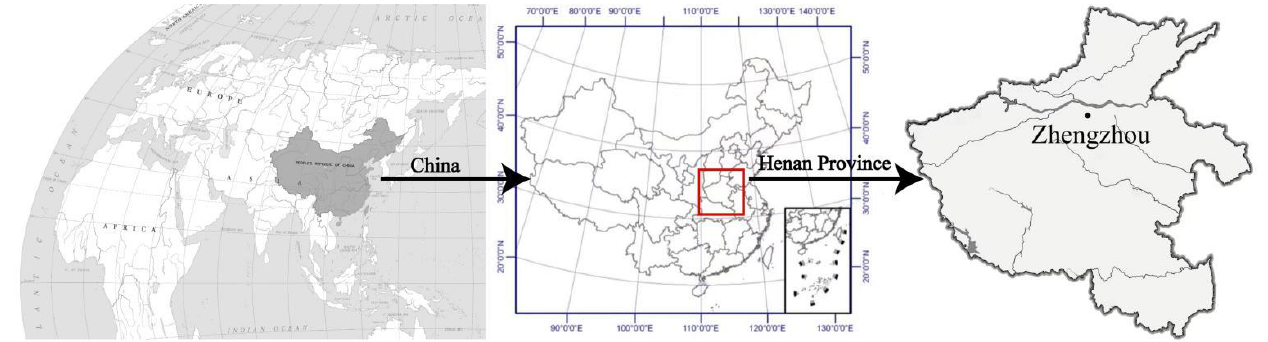
Figure 1. Distribution of sampling location in Henan Province, China. Table 1. Physicochemical parameters of water in